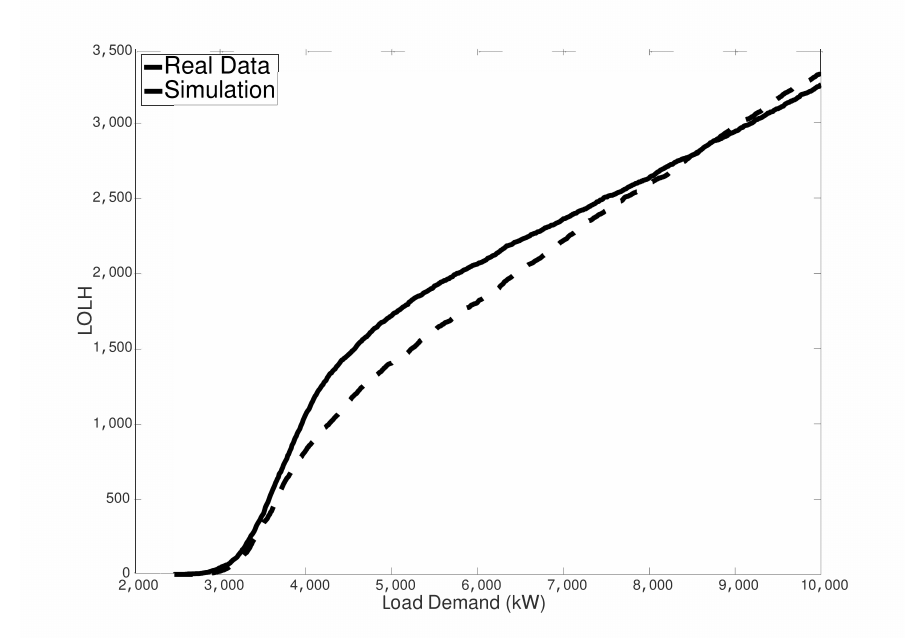
Figure 7. Empirical vs. simulated loss of load hours